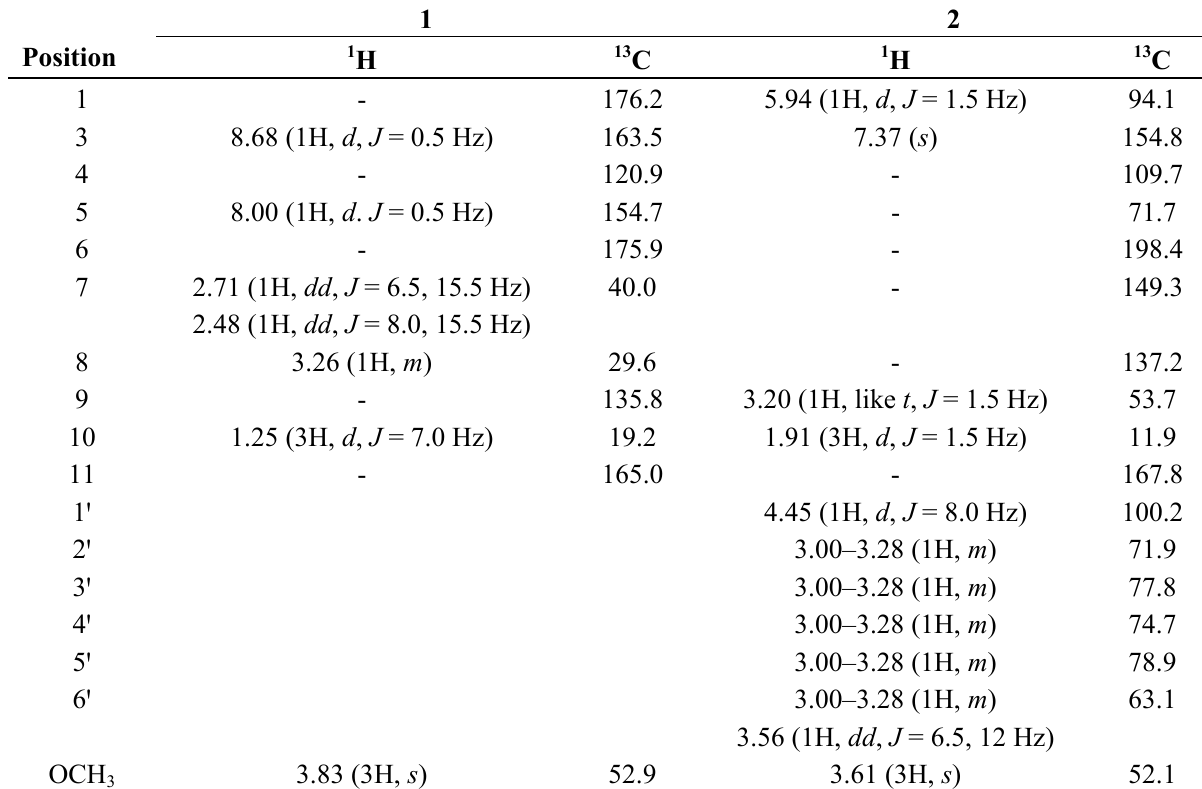
Table 1. The NMR spectroscopic data of compounds 1 and 2 (MeOH-d 500 MHz, 13 C - NMR 125